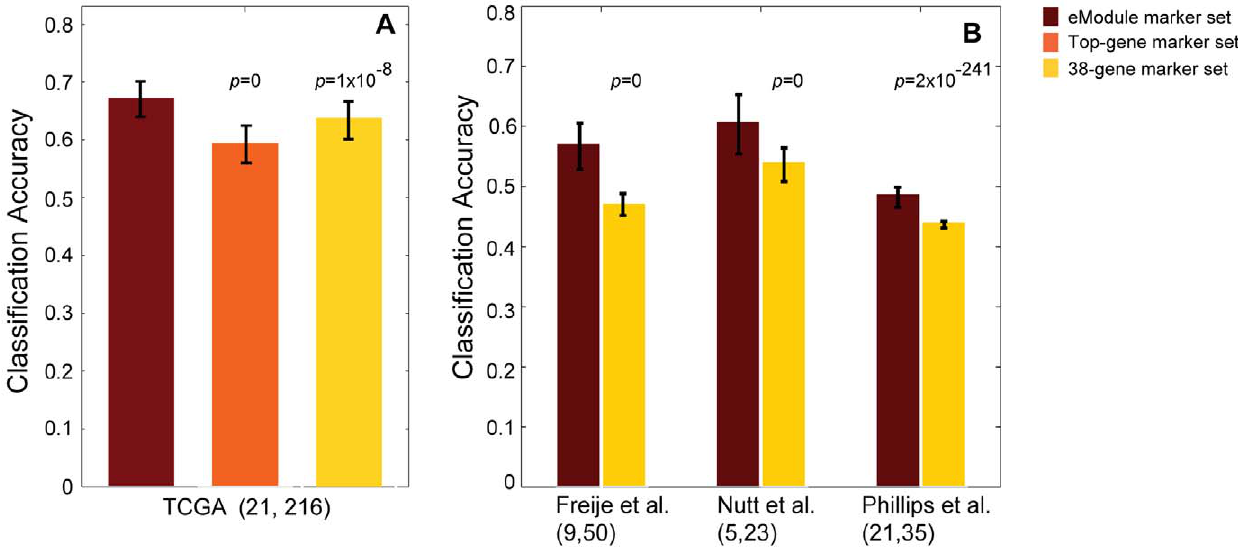
Figure 1. Performance comparison of gene-expression-based classifiers for GBM patient prognosis. A ) Prognostic accuracy of various marker sets. Classification accuracy is defined as the ratio of the number of correctly classified patients to the total number of patients tested. Expression data of 42 GBM patients was used to derive the eModule set. Top-gene set is top 156 (size-matched to the number of genes in the eModule set) most significantly differentially expressed genes between LTS and STS patients. 38-gene set, a set of 38 discriminative genes reported in [4]. Two hundred thirty seven additional GBM patients from TCGA were used for testing classification accuracy. Error bar is the standard deviation based on 100 leave-one-out cross validations. B ) Performance of eModule set and 38-gene set using three external microarray data [28–30] from which the 38-gene signature was derived. Numbers in parenthesis indicate number of LTS and STS in each data set, respectively. P-values are based on t-tests comparing the average classification accuracy of the eModule-based classifier and those of other